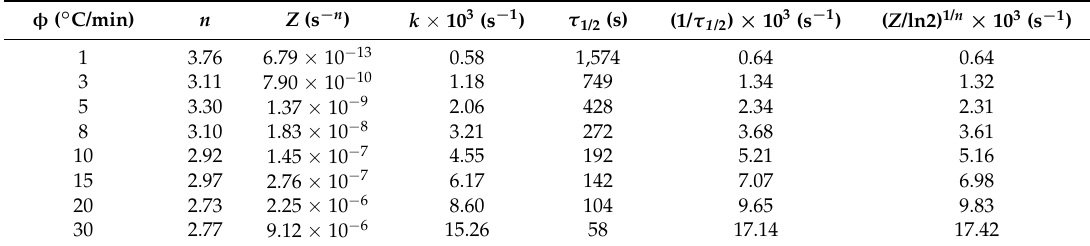
Table 1. Main non-isothermal crystallization kinetic parameters of polydioxanone (PDO) determined by differential scanning calorimetry